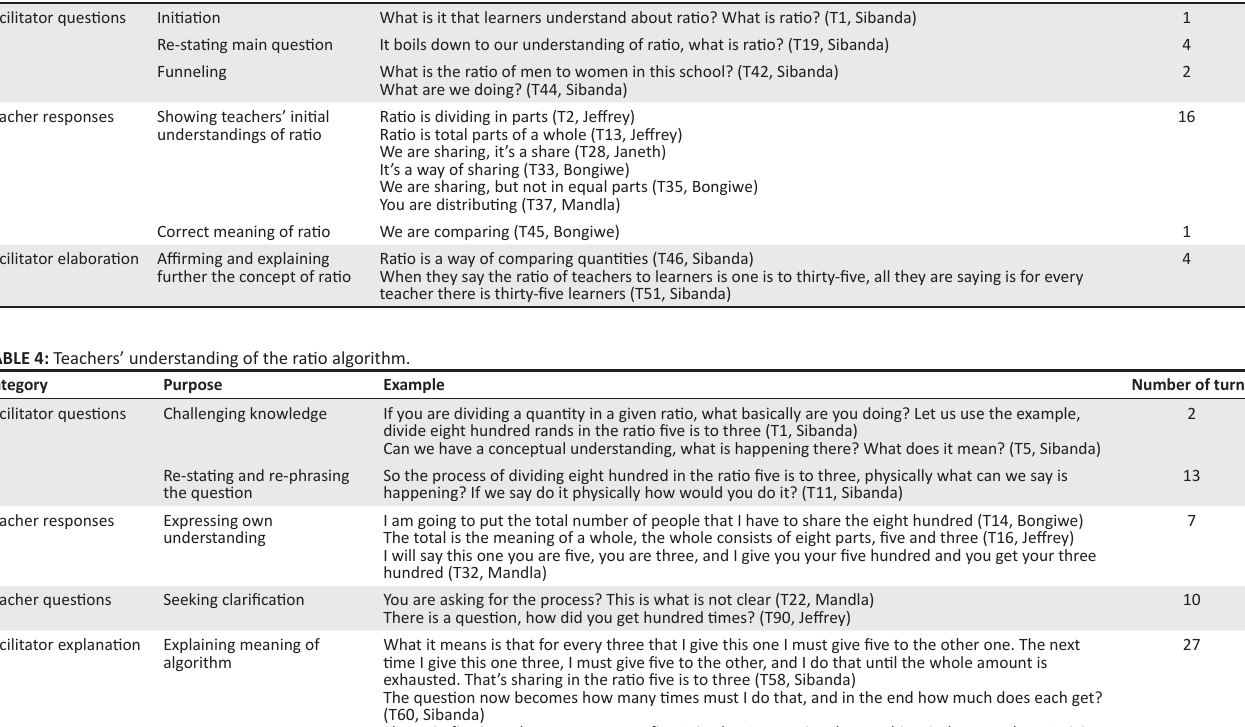
TABLE 3: Teachers’ understanding of the ratio concept. Category of utterance Purpose Example